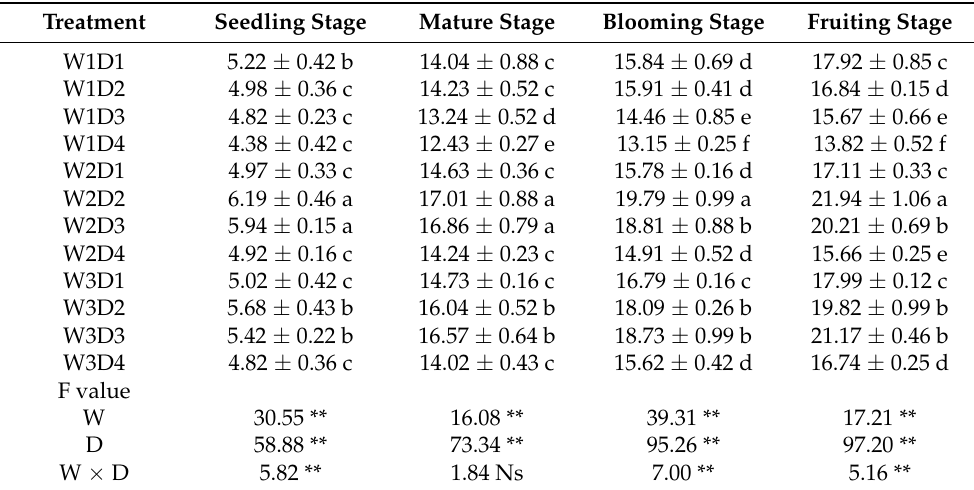
Table 4. Effect of different planting densities and irrigation volumes on the biomass of Suaeda salsa under drip irrigation. Treatment Seedling Stage Mature Stage Blooming Stage Fruiting